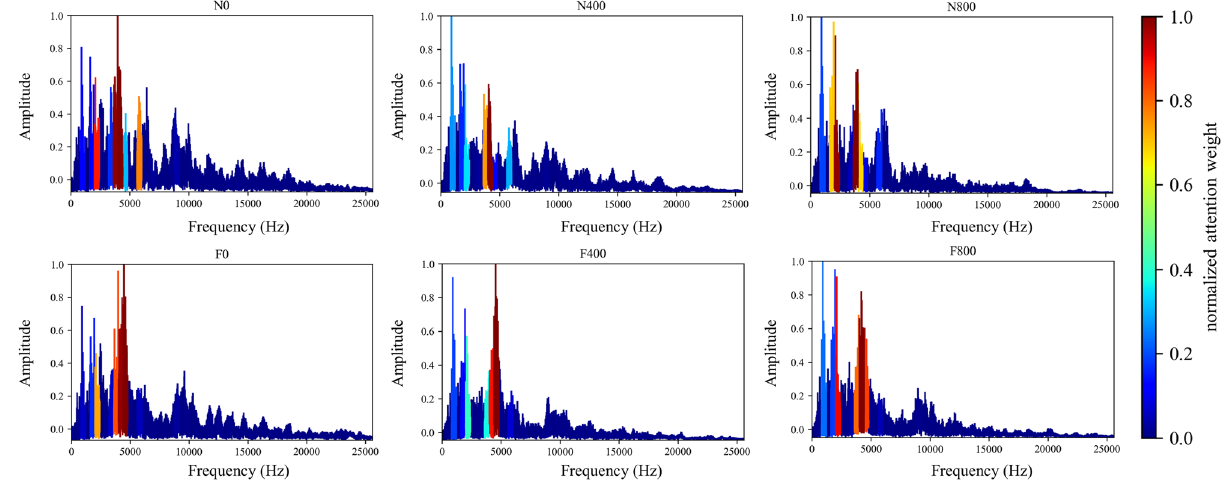
Figure 8. Visualization of attention weight on frequency domain signal of various working conditions.